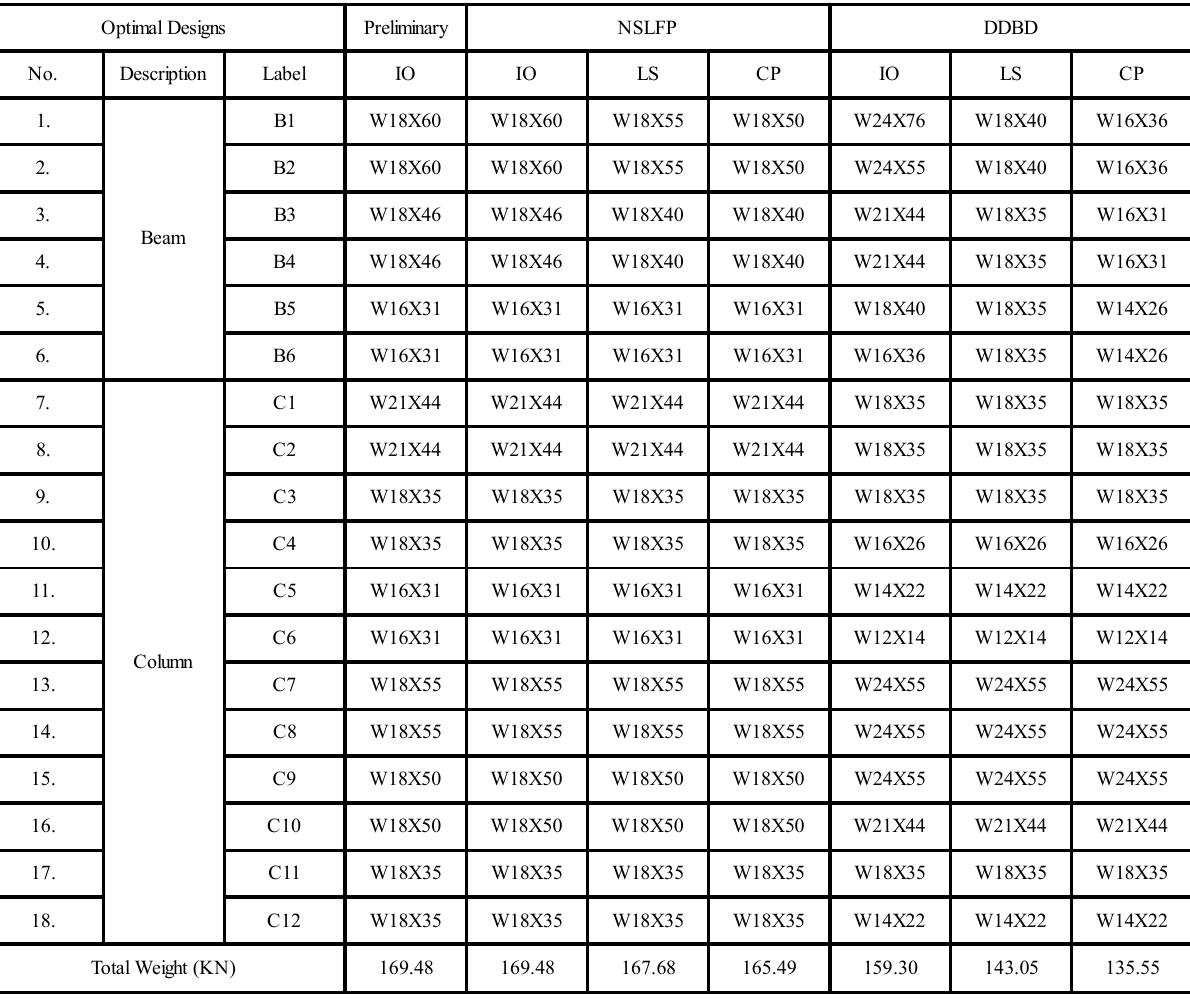
TABLE 2. OPTIMUM DESIGN